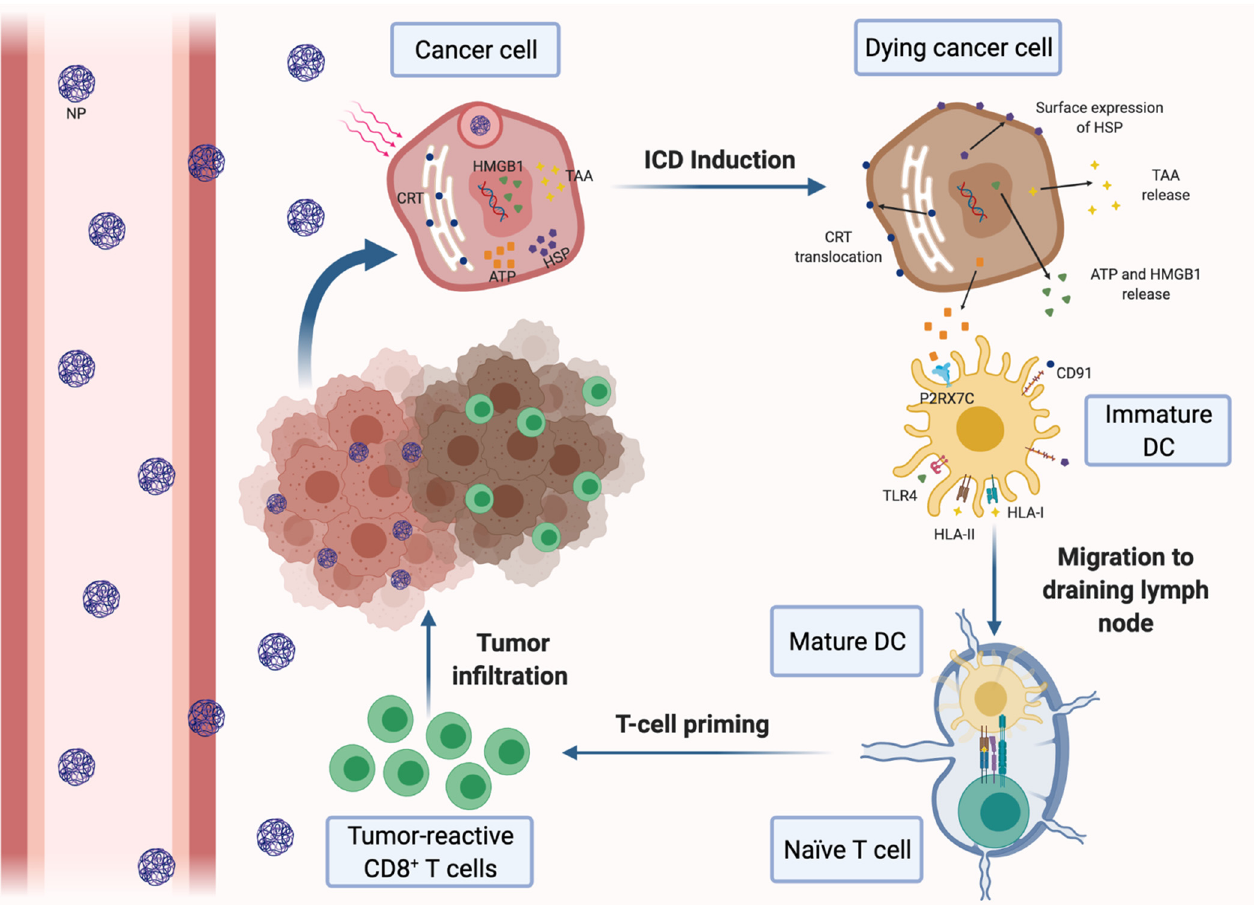
Figure 1. Induction of immunogenic cell death (ICD) of cancer cells by nanomedicine-based photodynamic or photothermal therapy. Nanoparticles (NPs) carrying a photodynamic agent extravasate blood vessels, reach breast tumors and are internalized by cancer cells, where they release their loading. Upon laser irradiation, the dying cancer cells secrete tumor-associated antigens (TAAs) and damage-associated molecular patterns (DAMPs), such as ATP and high-mobility group box 1 protein (HMGB-1). Tumor cells also express DAMPs on the cell surface, including calreticulin (CRT) and heat-shock proteins (HSP). DAMPs can be recognized by different pattern recognition receptors expressed on dendritic cells (DCs), resulting in their maturation and activation. Mature DCs migrate to the draining lymph nodes and induce the activation of tumor-specific effector CD8+ and CD4+ T cells, which infiltrate the tumor and mediate the specific antitumor immune response.